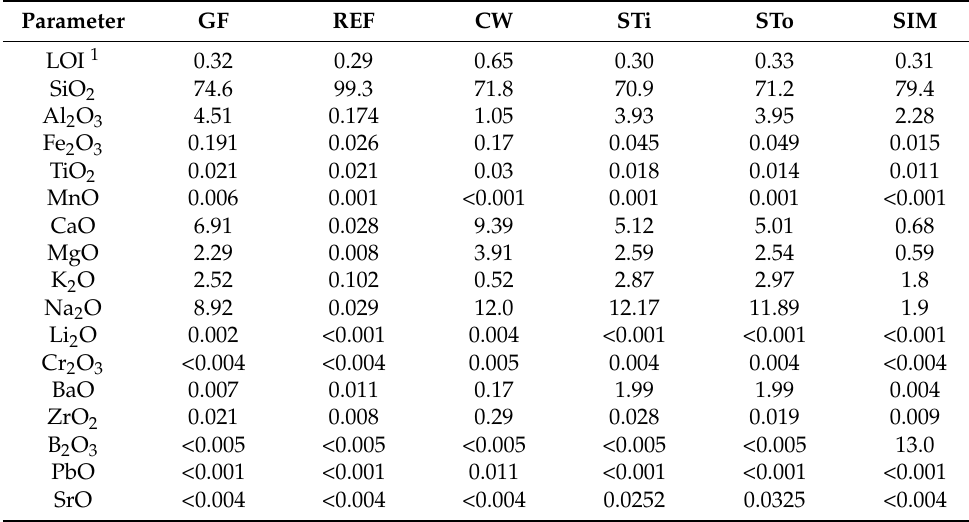
Table 1. Chemical composition of the fillers (% dry matter).